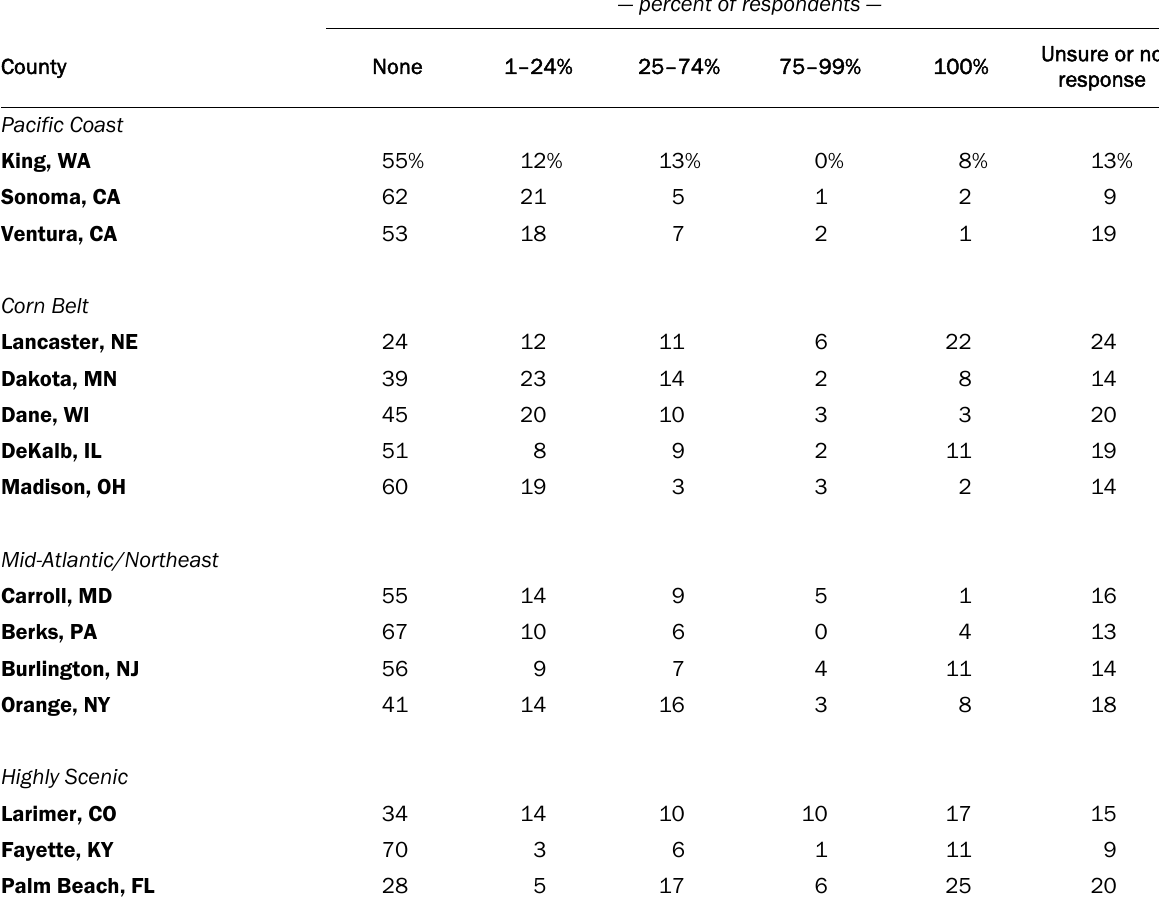
Table 3. Survey Respondents’ Expectations of the Amount of their Farmland They Expect to Develop within 10 Years, by County, 2005